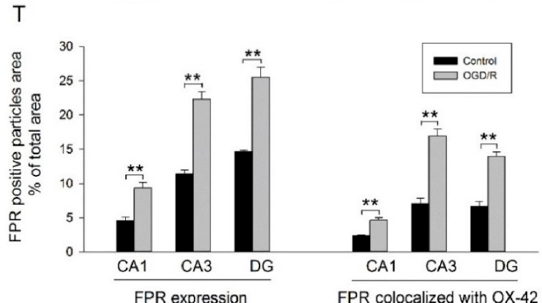
Figure 2. Oxygen–glucose deprivation/reperfusion (OGD/R) significantly elevated expression of formyl peptide receptors (FPRs) in hippocampal slices. ( A – S ) Examples of OX-42 (complement receptor Ш )-labeled microglia ( green ) and FPR-positive particles ( blue ); scale bar: 50 μ m; ( T ) fluorescence analysis illustrated the expression level of FPRs and the levels of FPRs co-localized with OX-42 in the CA1, CA3, and dentate gyrus (DG) before and after OGD/R. The data are expressed as the mean ± standard error of the mean (SEM) ( n = 3–8). ** p < 0.01.